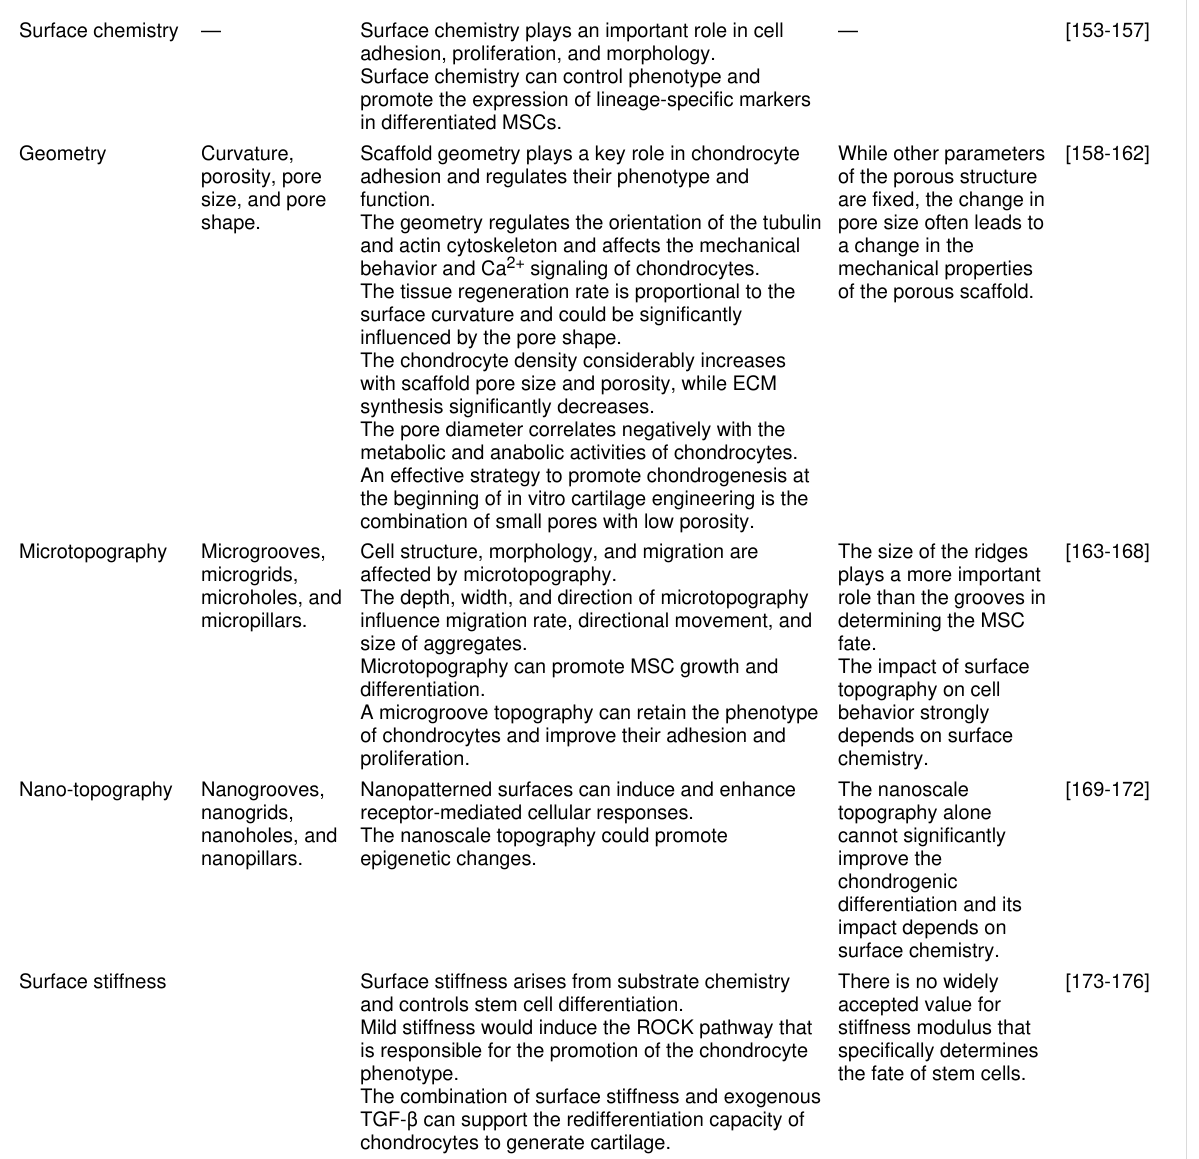
Table 2: Summary of the factors influencing cell fate that should be taken into account when designing a scaffold. (continued) Surface chemistry